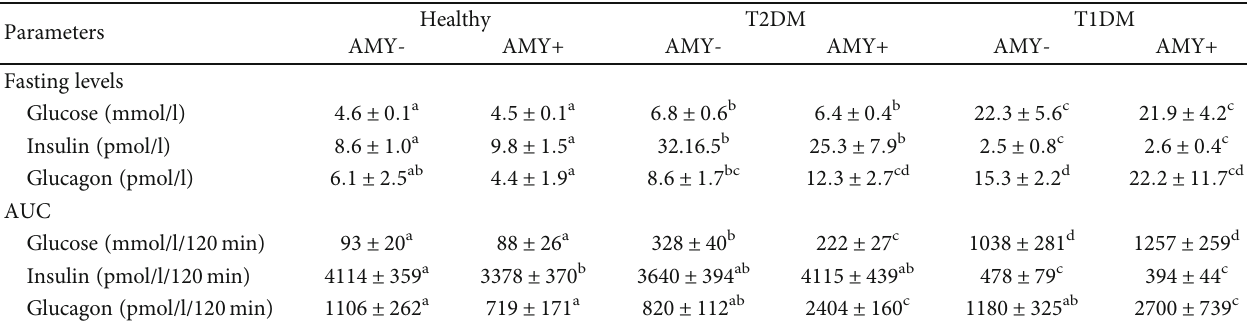
Table 1: The fasting and postprandial blood levels of glucose, insulin, and glucagon in control and STZ-induced type 2 and type 1 diabetic pigs. Healthy Parameters